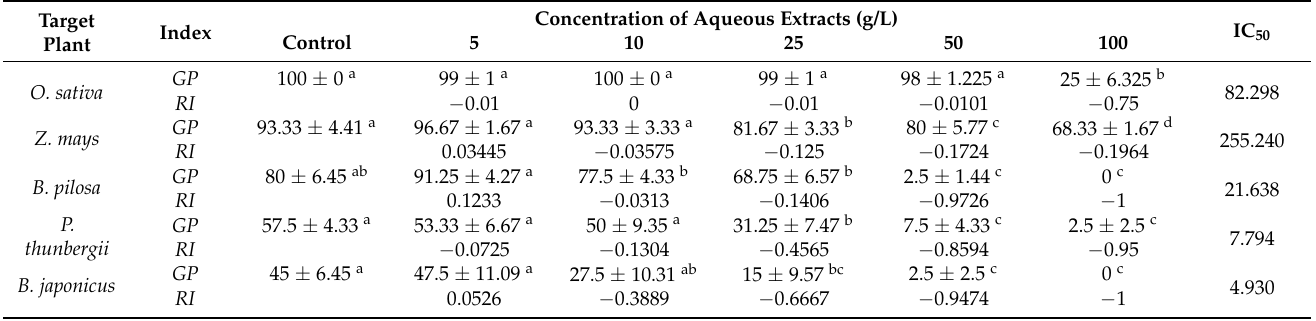
Table 1. Effects of fleagrass aqueous extracts on the seed germination percentage of five target plants.